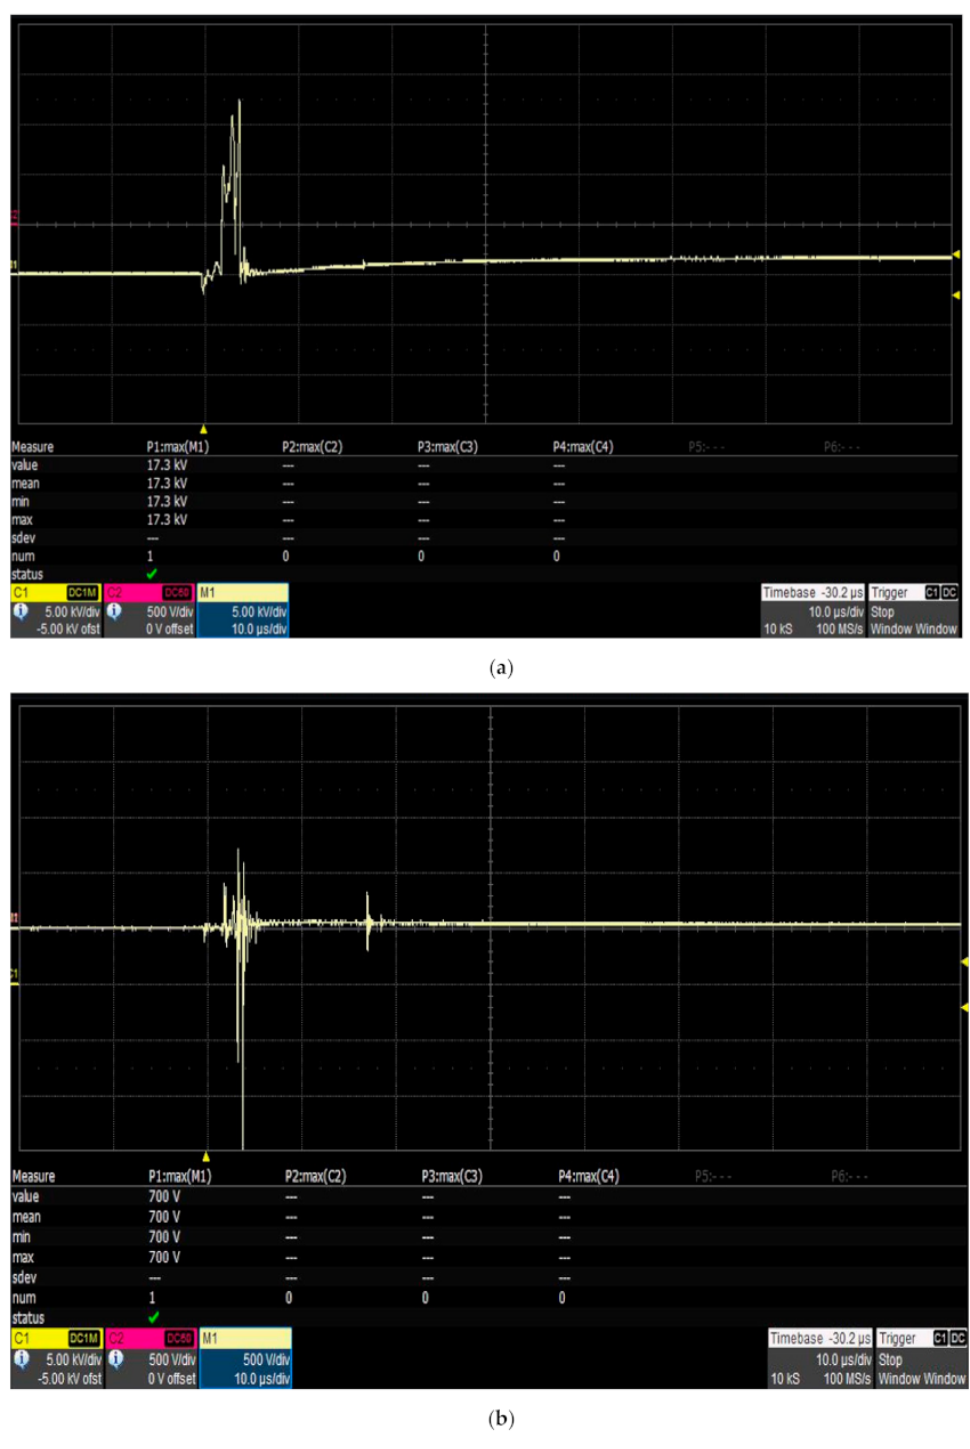
Figure 4. Measured traces on the modem for the case of damage to the modem for configuration (d), installed at site 2b ( a ) Voltage trace measured with voltage divider 2 (x scale is 10 µ s/div, and y scale is 5 kV/div); ( b ) Current flows through the modem, measured with current transformer (CT) 2 (x scale is 10 µ s/div, and y scale is 5 kV/div, and the voltage magnitude is multiplied by 10, since the CT used had a sensitivity of 0.1